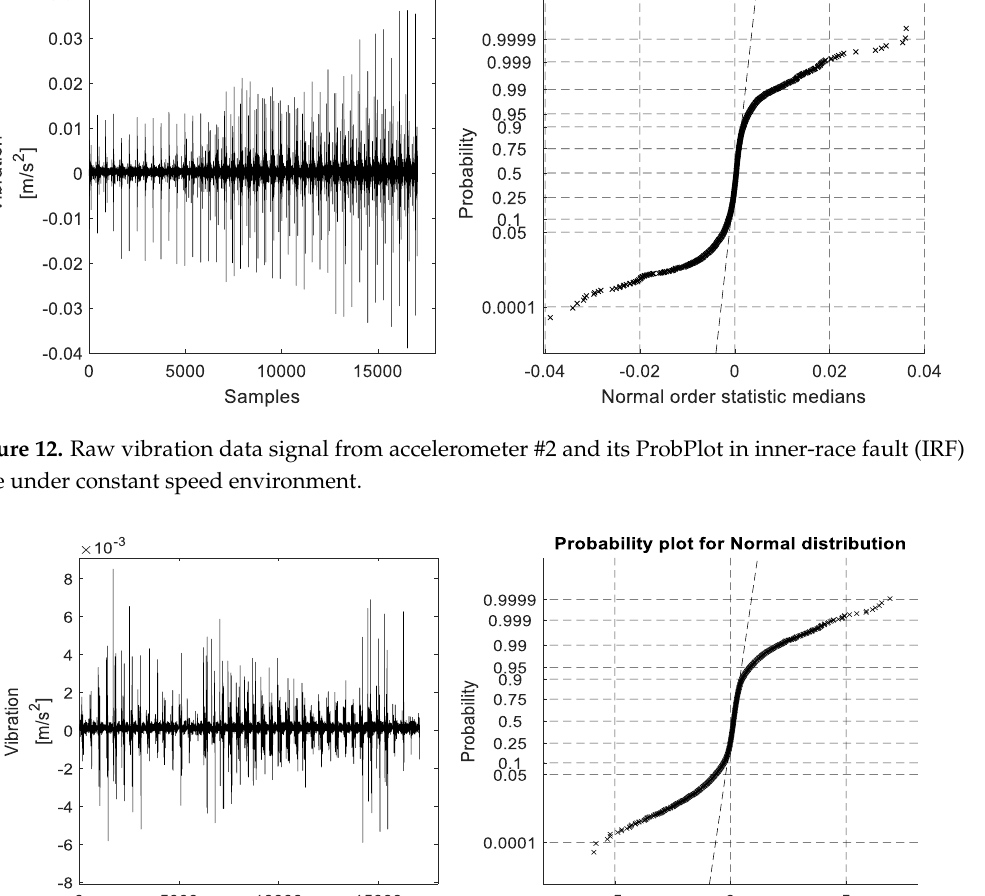
Figure 13. Raw vibration data signal from accelerometer #2 and its ProbPlot in ball bearing fault (BBF) case under constant speed environment.